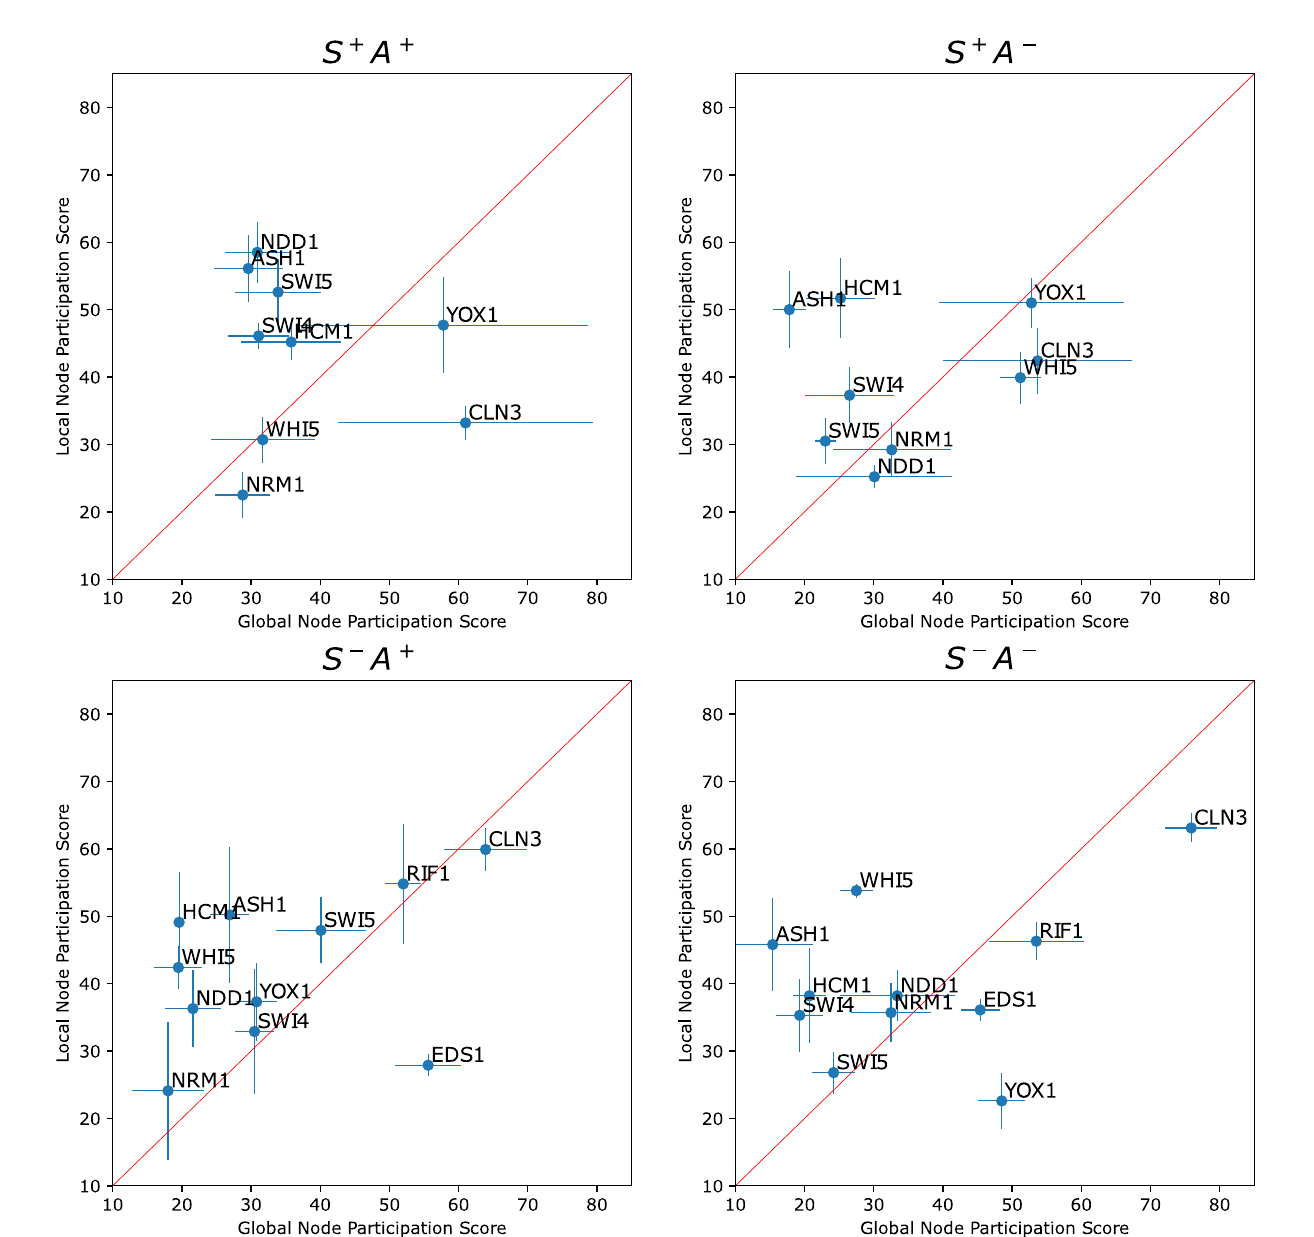
Fig 7. Local versus global node participation scores for the yeast cell cycle network. Mean ± standard deviation node participation scores for the four scenarios S + A + , S + A − , S − A + , and S − A − . Each scenario was run through the edge and network finding steps five times. The mean (blue dots) and standard deviation (blue bars) of the local node participation scores across the five runs is plotted against the mean and standard deviation of the global node participation scores. The node participation score for each simulation is computed only over the edges in the intersection of the top-ranked LEM edges of all five simulations. This excludes edges that do not have sufficiently high local edge ranks in all five simulations. Nodes located above the red diagonal line indicate an improved global node participation score versus their local node participation score.